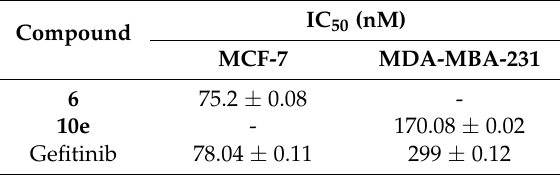
Table 3. IC 50 values of EGFR assay for the most active compounds— 6 and 10e —and the reference gefitinib. Values are expressed as the mean ± SD of at least three independent experiments.